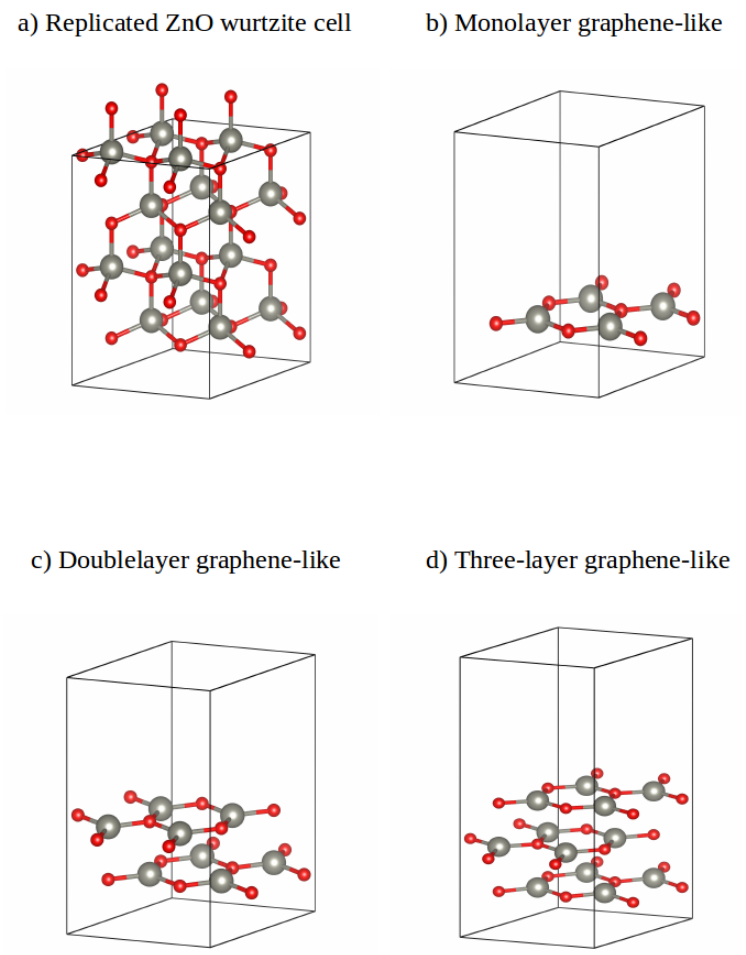
Figure 1: Replicated wurtzite structure along the xyz directions (a) and two-dimensional ZnO graphene-like structures (b, c and d). The geometries were obtained after